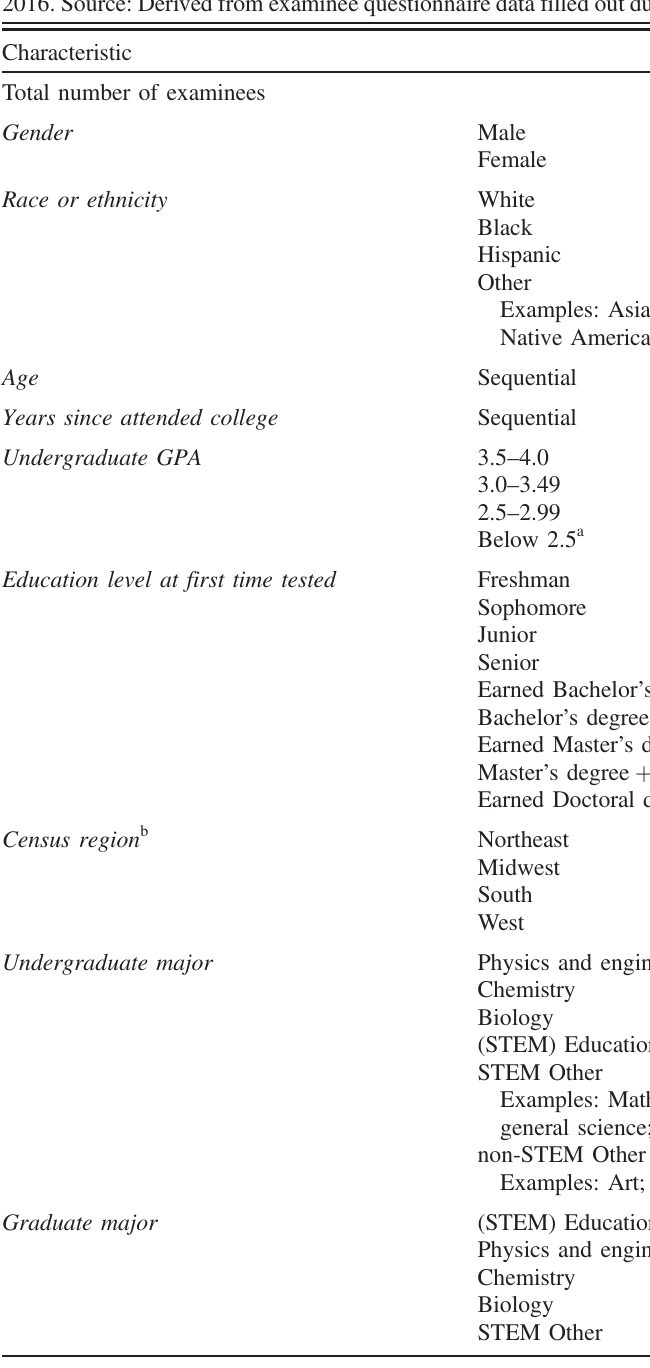
TABLE III. Detailed list of personal and professional characteristics of Praxis physics subject assessment Examinees from 2006